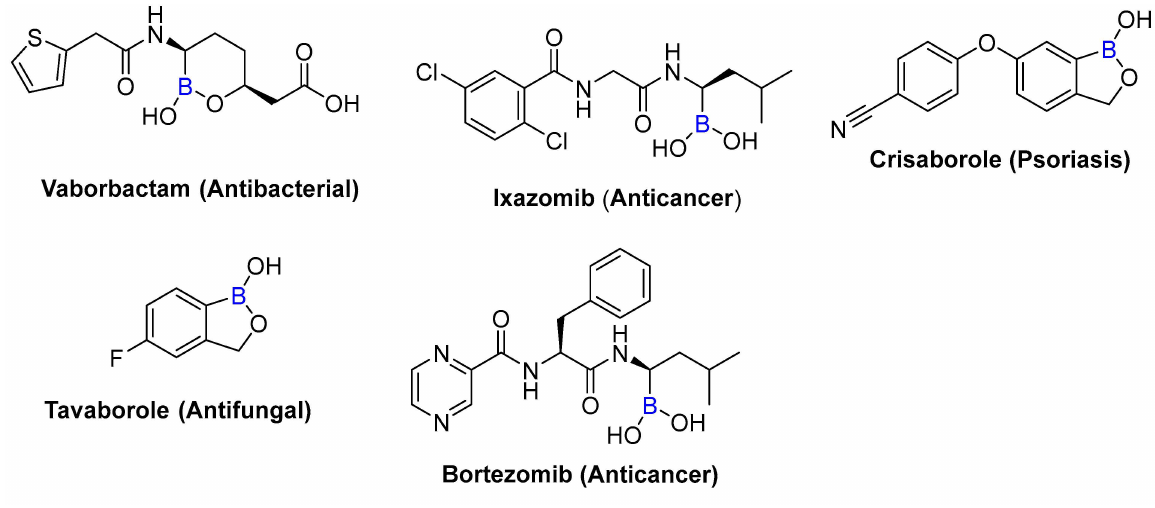
Figure 2. Boron-based compounds approved by the FDA for various therapeutic purposes.